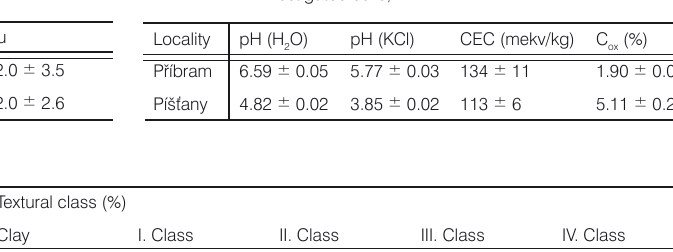
Table 1. Total content of heavy metals (mg kg -1 ) for investigated metals in both soils, n=4.